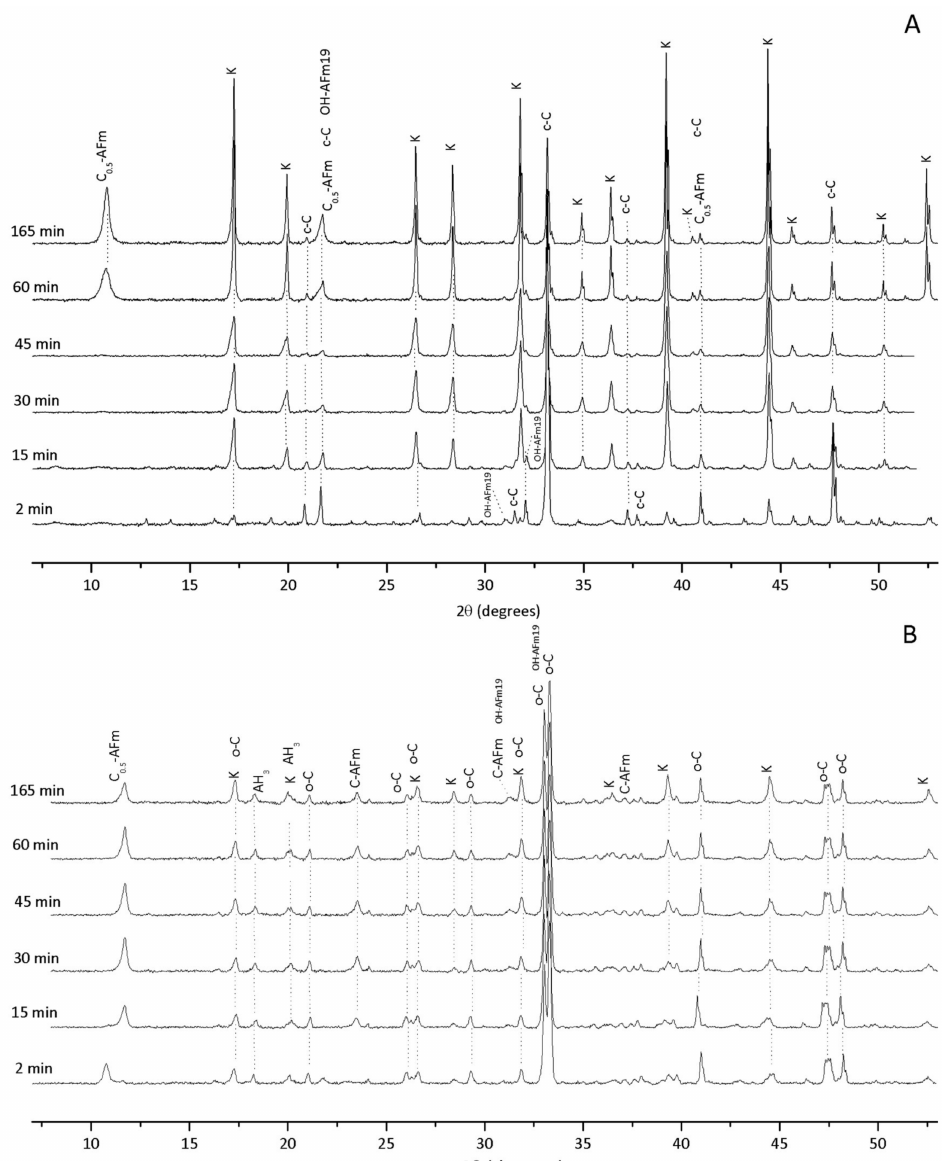
Figure 2. In situ X-ray diffraction (XRD) results for ( A ) cub-C 3 A and ( B ) orth-C 3 A hydration without gypsum. OH-AFm 19 = C 4 AH 19 ; C 0.5 -AFm = calcium hemicarboaluminate hydrate; AH 3 = gibbsite; k = katoite (C 3 AH 6 ); c-C = cub-C 3 A; and o-C = orth-C 3